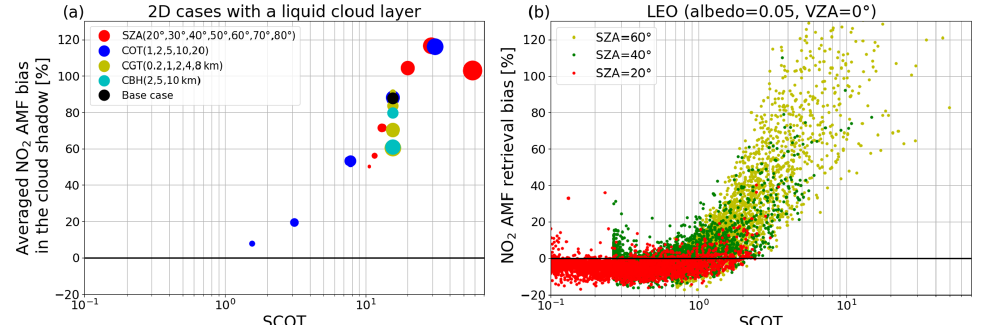
Figure 10. NO 2 AMF retrieval bias as a function of slant cloud optical thickness. (a) Box-cloud cases with the liquid cloud. The bias is averaged over all the pixels in the cloud shadow, and the various colours and marker sizes represent cases with different solar zenith angles, cloud optical thicknesses, cloud geometric thicknesses, and cloud bottom heights. (b) Synthetic data with LES clouds for low Earth orbit (LEO) satellite geometries (VZA = 0 ◦ , SZA = 20, 40, and 60 ◦ ) and a surface albedo of 0.05. The black line shows the bin average with standard deviations (error bars). Only retrievals with CF w < 50% are used.